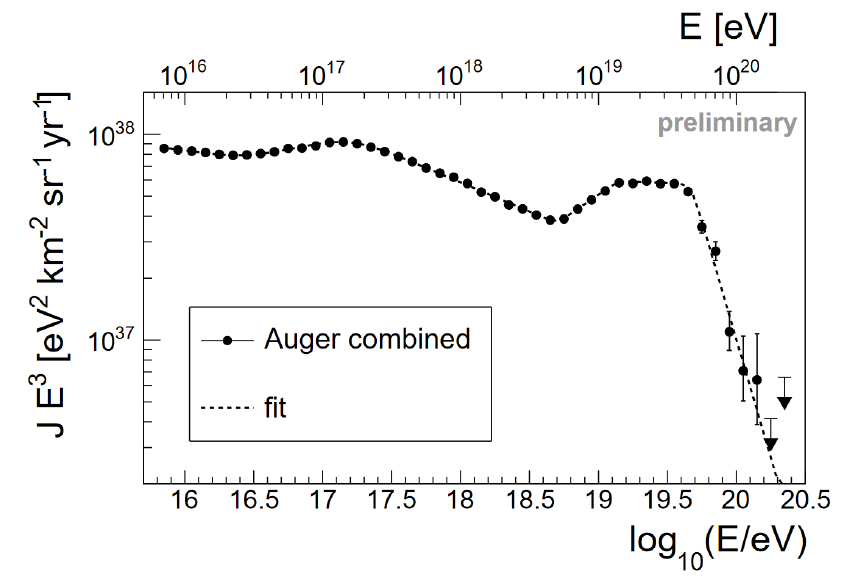
Figure 8. Combined energy spectrum, multiplied by E 3 and best fit function, presented in